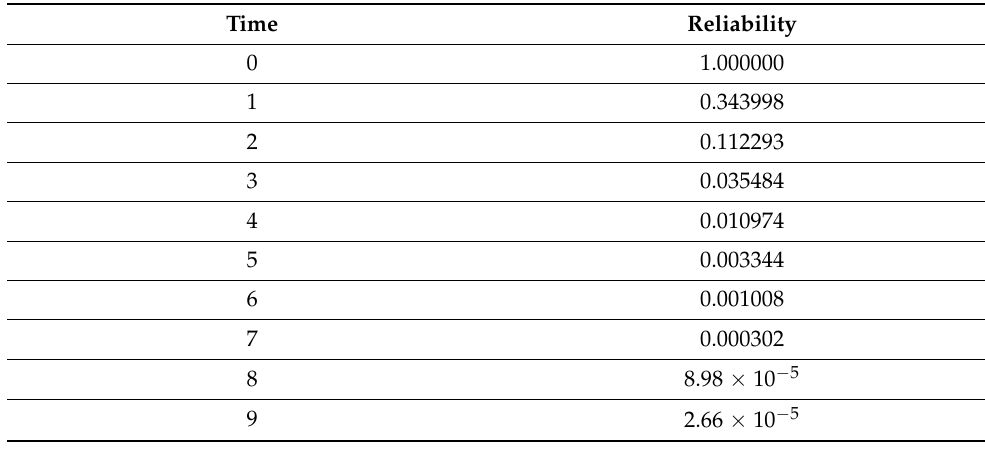
Table 2. Time vs. Reliability.